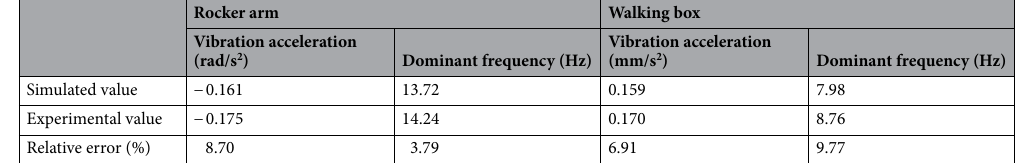
Table 7. Comparison of simulated and experimental values.